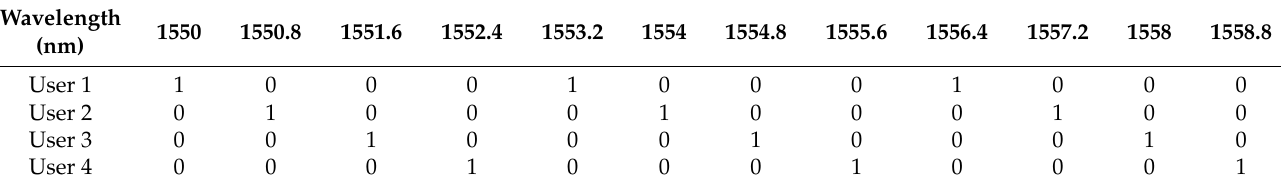
Table 3. Parameter values for MDM-based FSO-OCDMA Table 2. MNZCC code design for four users at Donut mode 1.